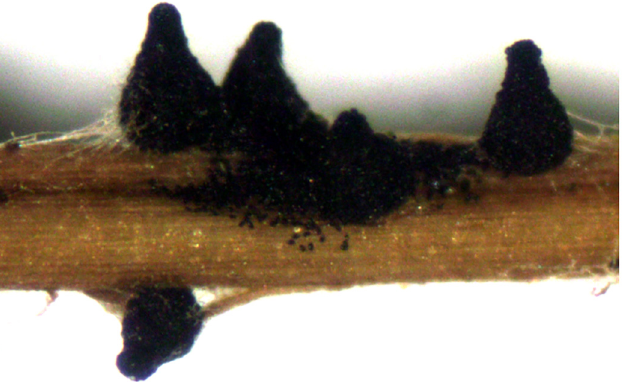
Fig 3. Abundant reproduction on plant tissues. Mature perithecia of S . fimicola CID 323 on autoclaved, senescent B . tectorum leaf